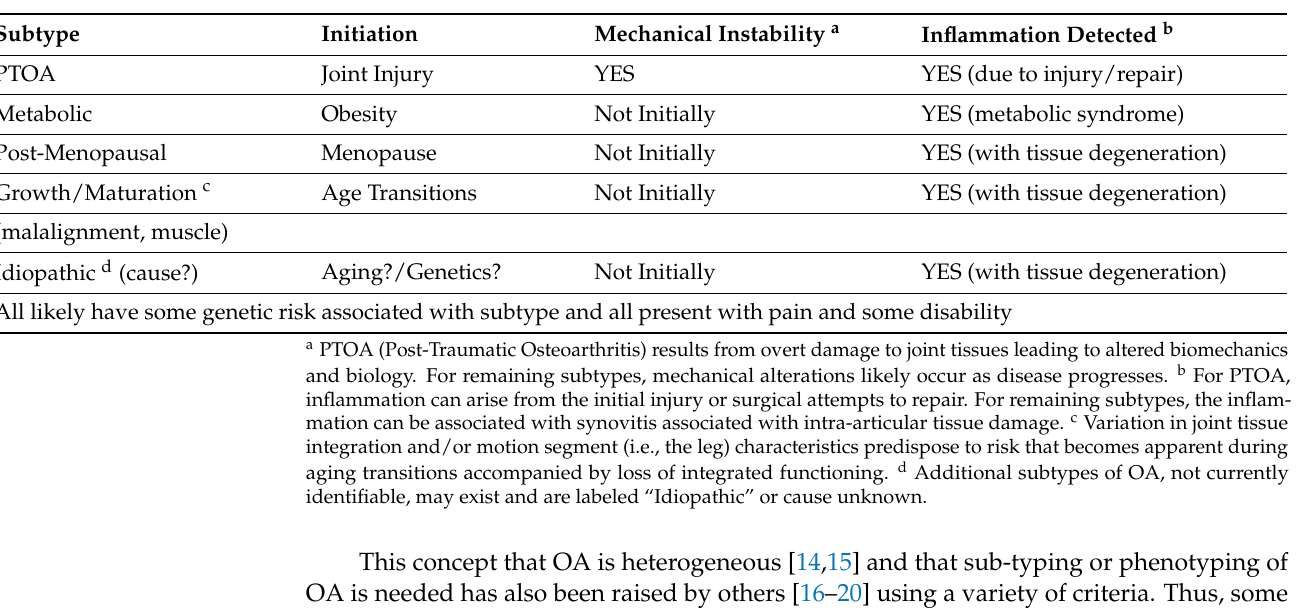
Table 1. Subtypes of Knee